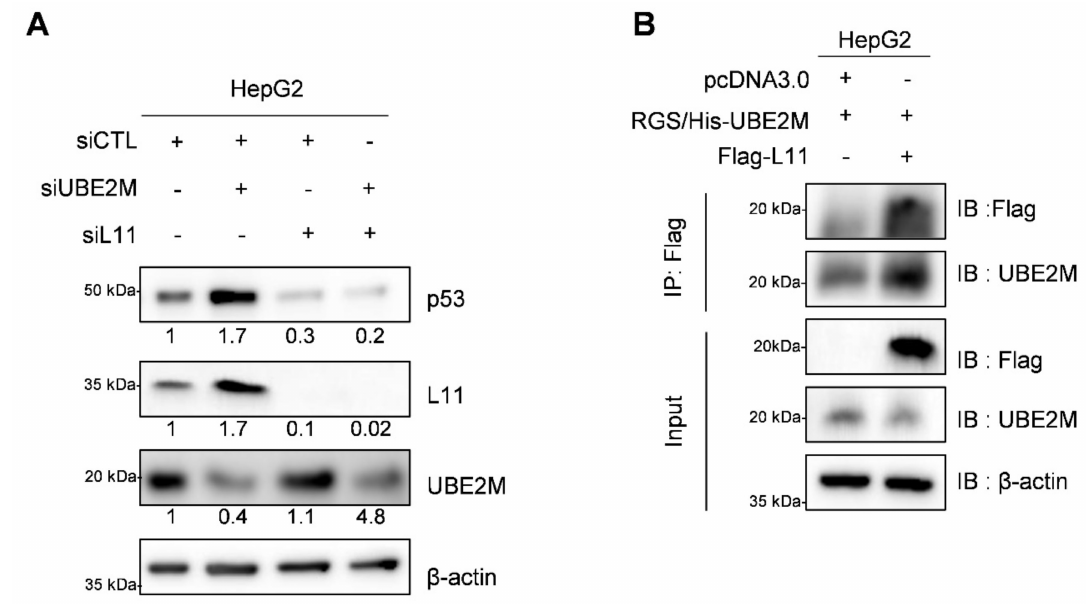
Figure 6. Ribosomal protein L11 is required for p53 activation by UBE2M depletion in HepG2 cells. ( A ) UBE2M depletion activates p53 in the presence of L11. HepG2 cells were co-transfected with control siRNA, UBE2M siRNA and L11 siRNA and were subjected to Western blotting with antibodies of p53, L11, UBE2M and β actin. Total siRNA amount of its transfection mixture was adjusted to 80 nM per one well in 6-well plates. ( B ) UBE2M binds to L11 in HepG2 cells by immunoprecipitation. HepG2 transfected cells with pcDNA3.0, RGS/His-UBE2M and Flag-L11 plasmids were lysed and